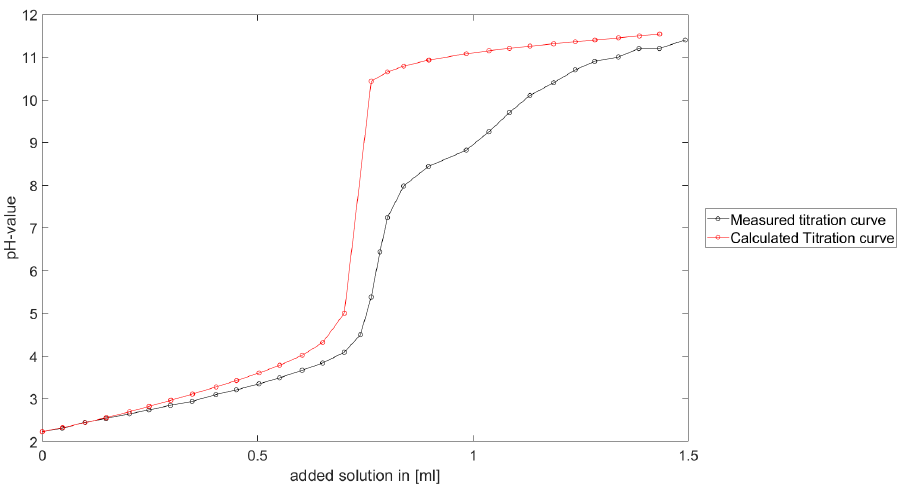
Figure 14. Comparison of the expected titration curve and the calculated titration curve for a Cit-Ni electrolyte, with stability constants from literature, c.f., Table 8.